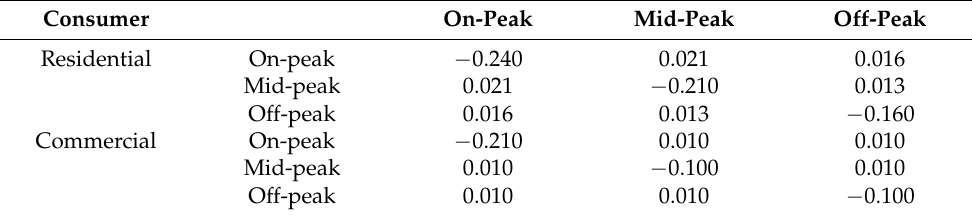
18:00 h. Table 2 shows self and cross elasticity data adopted for these periods. Table 2. Self and Cross Elasticities for Different Type of Consumers.